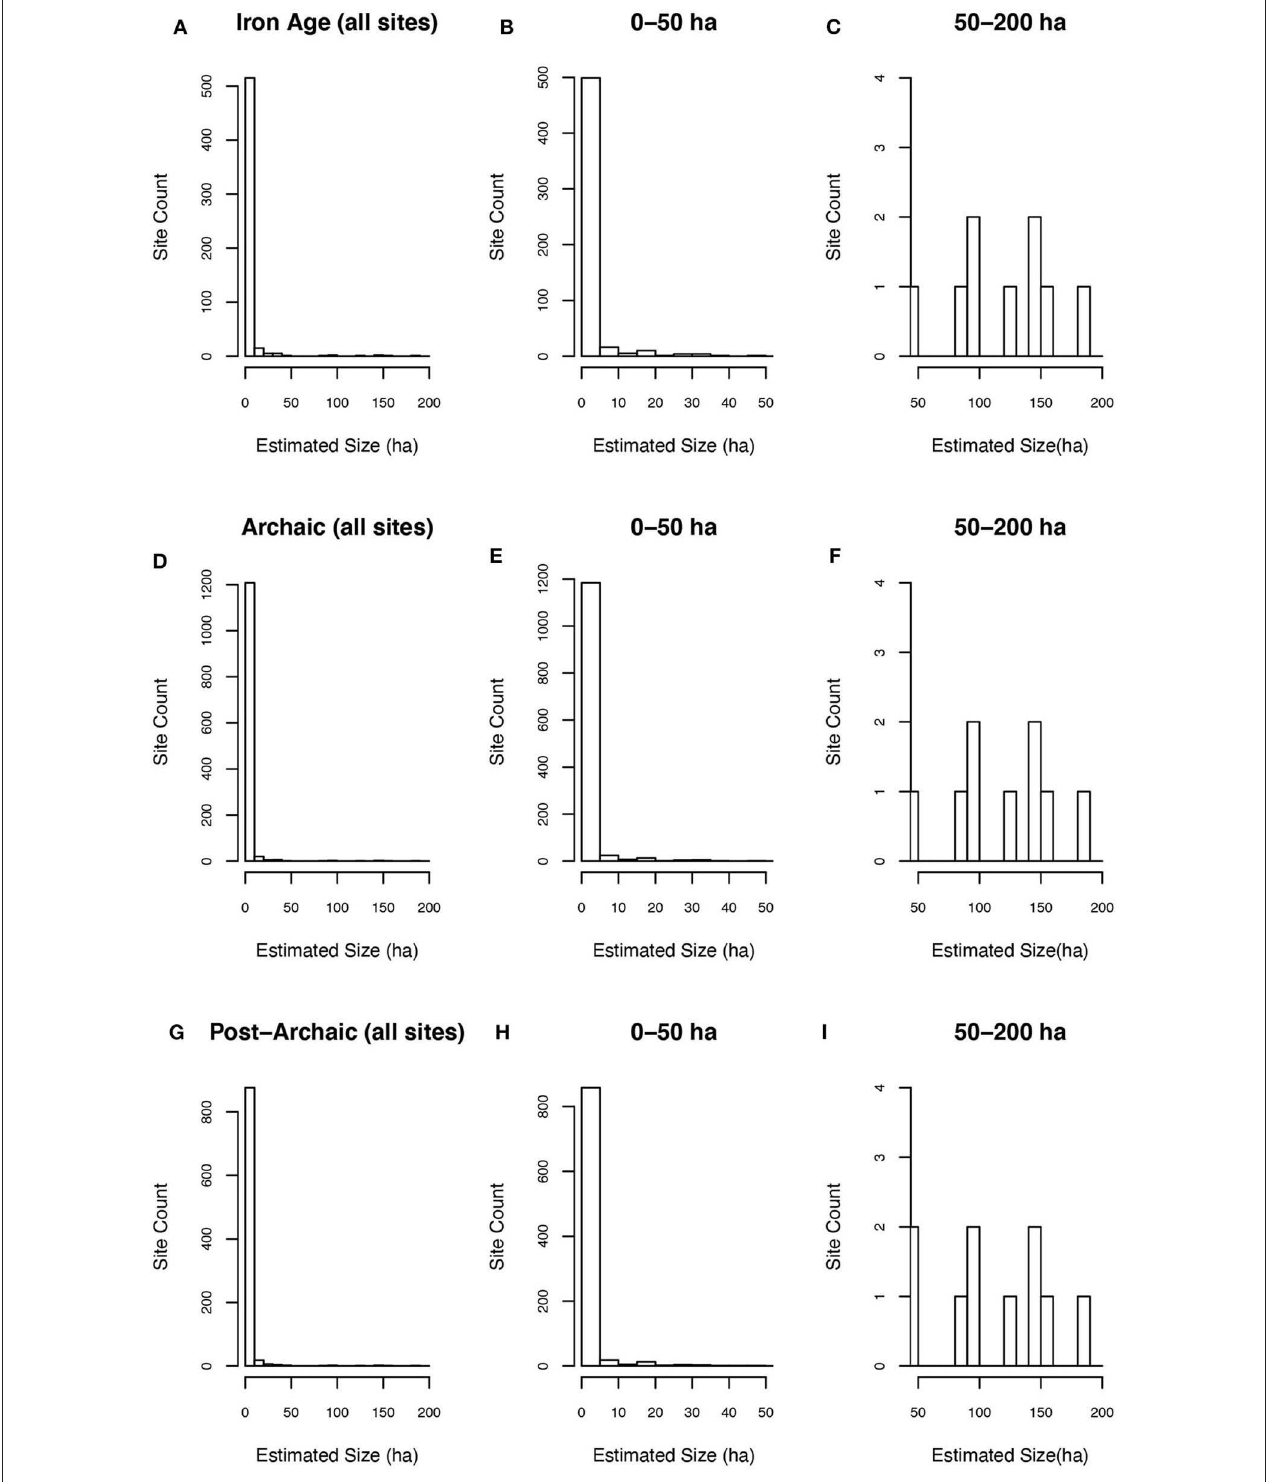
FIGURE 4 | Histograms of site size frequency for Etruria by period. (A) All sites in the Iron Age and Orientalizing. (B) Iron Age and Orientalizing sites measuring 0–50 hectares. (C) Iron Age and Orientalizing sites measuring 50–200 hectares. (D) All sites in the Archaic Period. (E) Archaic sites measuring 0–50 hectares. (F) Archaic sites measuring 50–200 hectares. (G) All Post-Archaic sites. (H) Post-Archaic sites measuring 0–50 hectares. (I) Post-Archaic sites measuring 50–200 hectares.